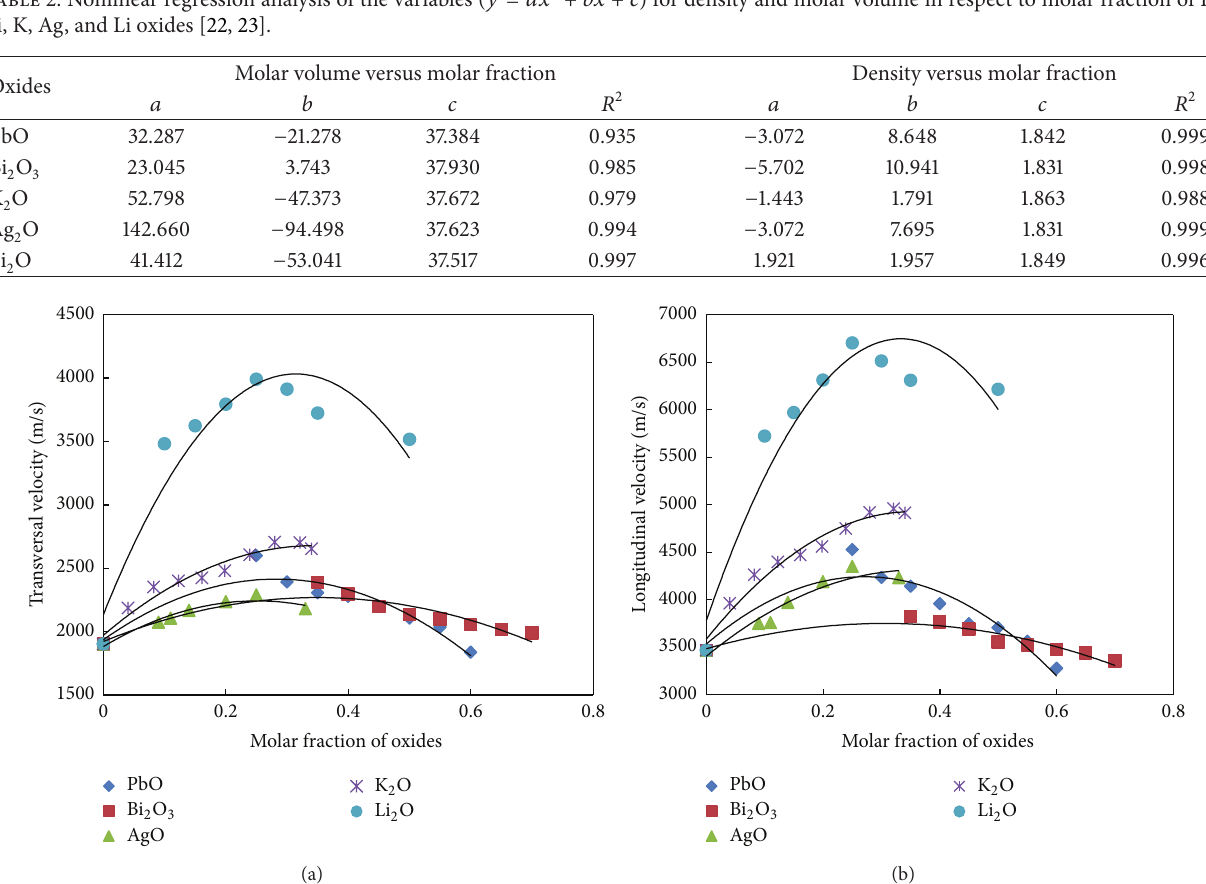
Figure 3: (a) Transverse ( 𝑉 𝑠 ) and (b) longitudinal ( 𝑉 𝑙 ) sound velocities of binary borate glasses as a function of modifier oxide contents of Pb and Bi oxides with those of Ag, K, and Li [22, 23].